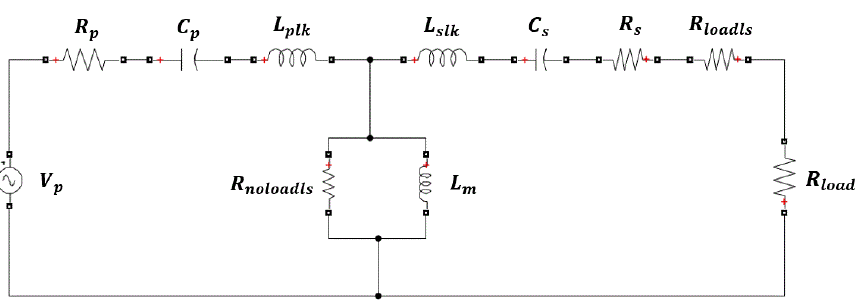
Figure 11. Simulation CLLC circuit.